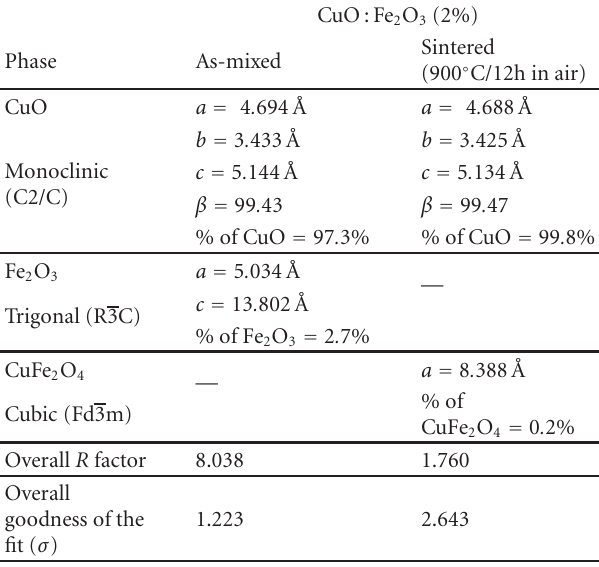
Table 2: Structural and compositionalparameters of bulk as-mixed and sintered CuO : Fe 2 O 3 (2%) along with possible secondary phases from Rietveld Refinement of the X-ray